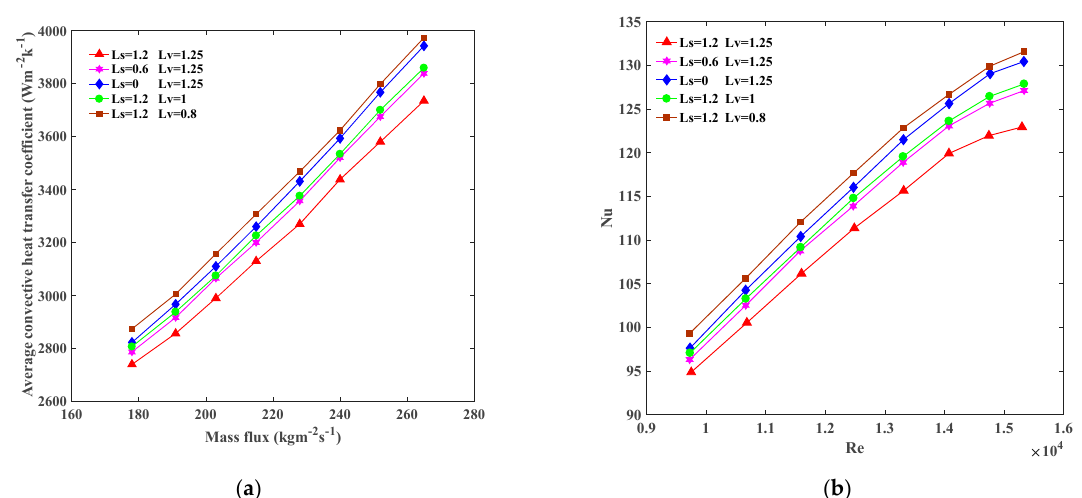
Figure 9. The average convective heat transfer coefficient versus mass flux and Nu versus Re for different fin arrangements: ( a ) average convective heat transfer coefficient versus mass flux; ( b ) Nu versus Re.